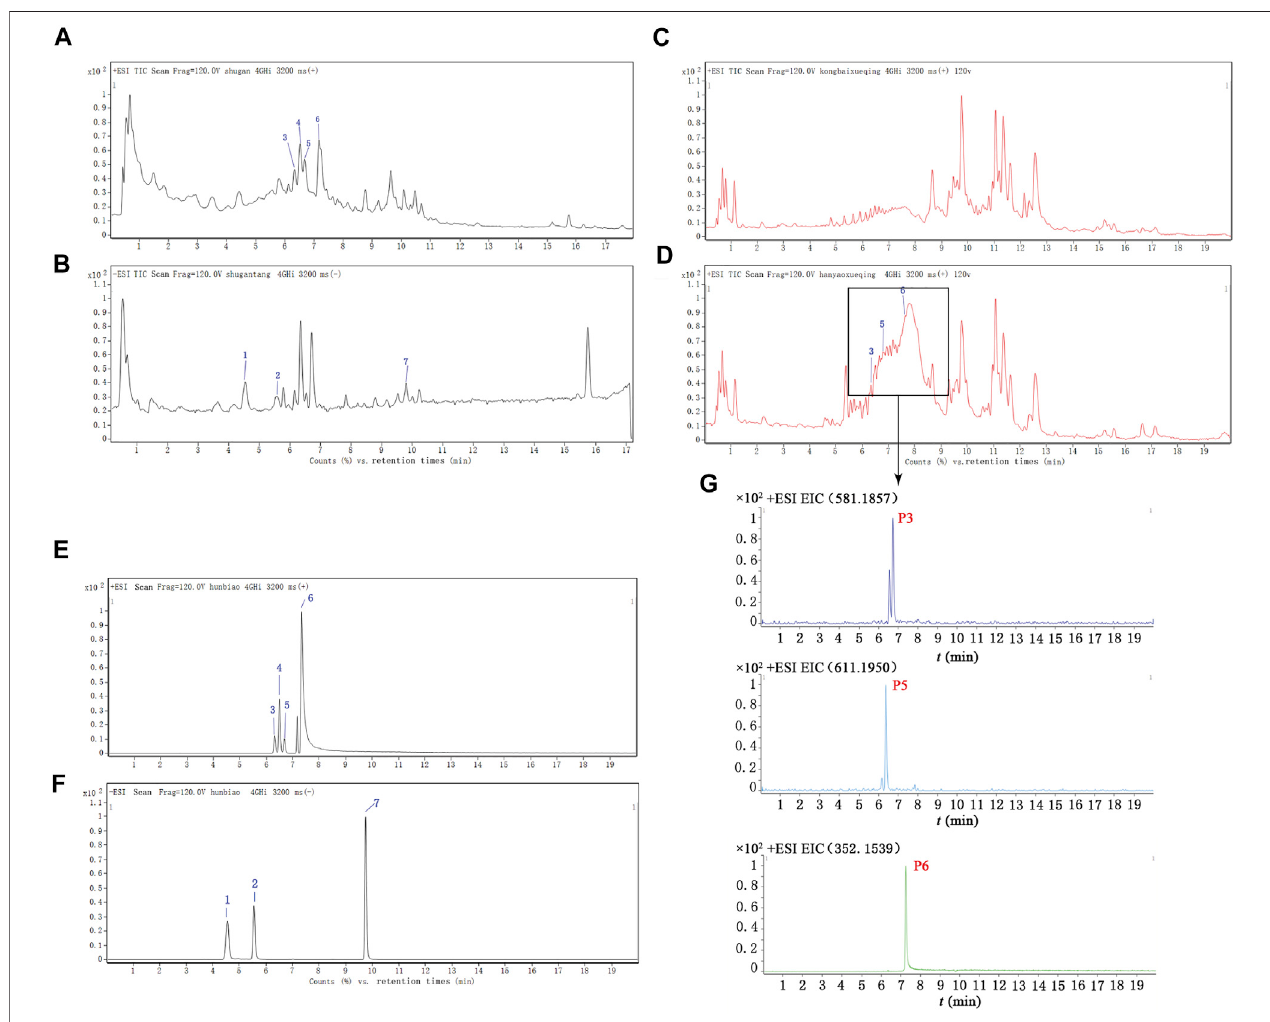
FIGURE 3 | Total ion chromatograms (TICs) for SHD, the SHD-containing serum, and the standard substances. (A) The TIC for SHD in the positive mode. (B) The TIC for SHDinthe negative mode. (C) The TIC forthecontrolserum inthe positivemode. (D) TheTIC fortheSHD-containingserum inthepositivemode. (E) TheTIC for the standard substances in the positive mode. (F) The TIC for the standard substances in the negative mode. (G) The ion intensity of the three prototype components identi fi ed in the SHD-containing serum. The numbers marked in the fi gure correspond to (1) paeoni fl orin, (2) liquiritin, (3) naringin, (4) hesperidin, (5) neohesperidin, (6) palmatine chloride, and (7) Saikosaponin A.